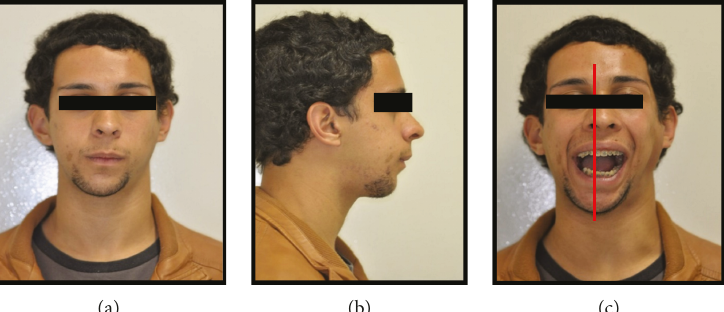
Figure 10: (a), (b), and (c) Postsurgery pictures after seven days emphasizing a more harmonic facial pro fi le and improvement of the mouth opening and the mandibular deviation.